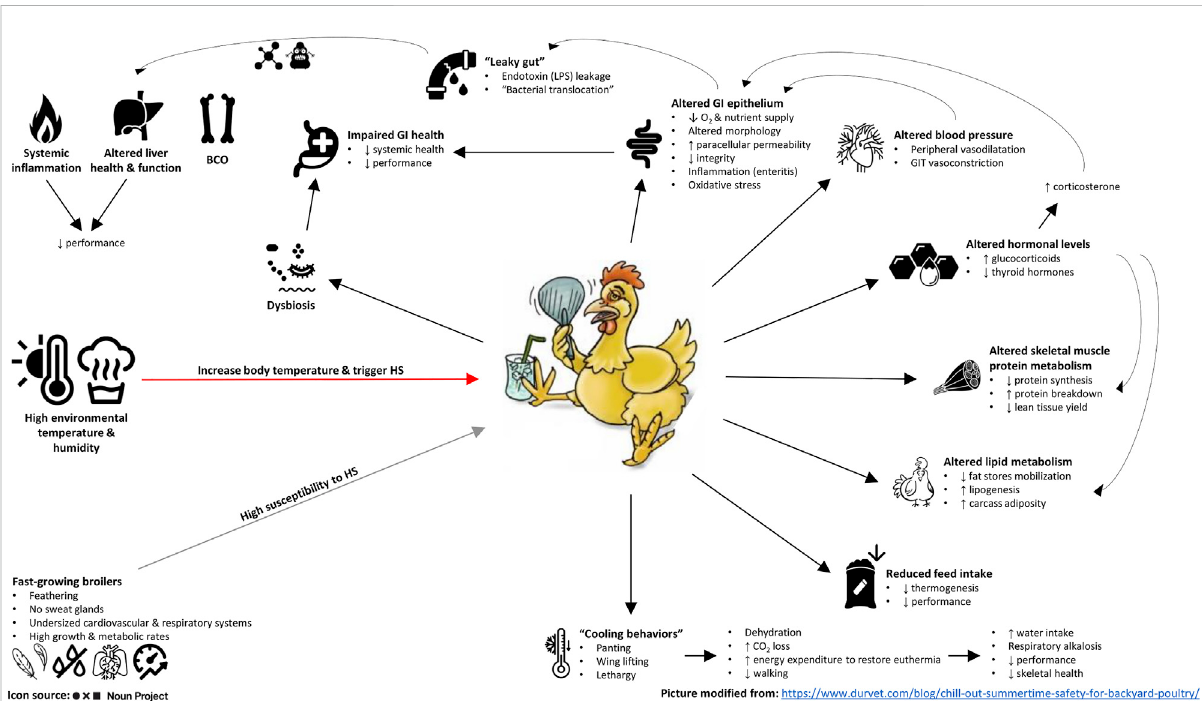
FIGURE 1 Summary chart of the main effects of heat stress on modern (broiler) chicken lines. LPS, lipopolysaccharides; BCO, bacterial chondronecrosis with